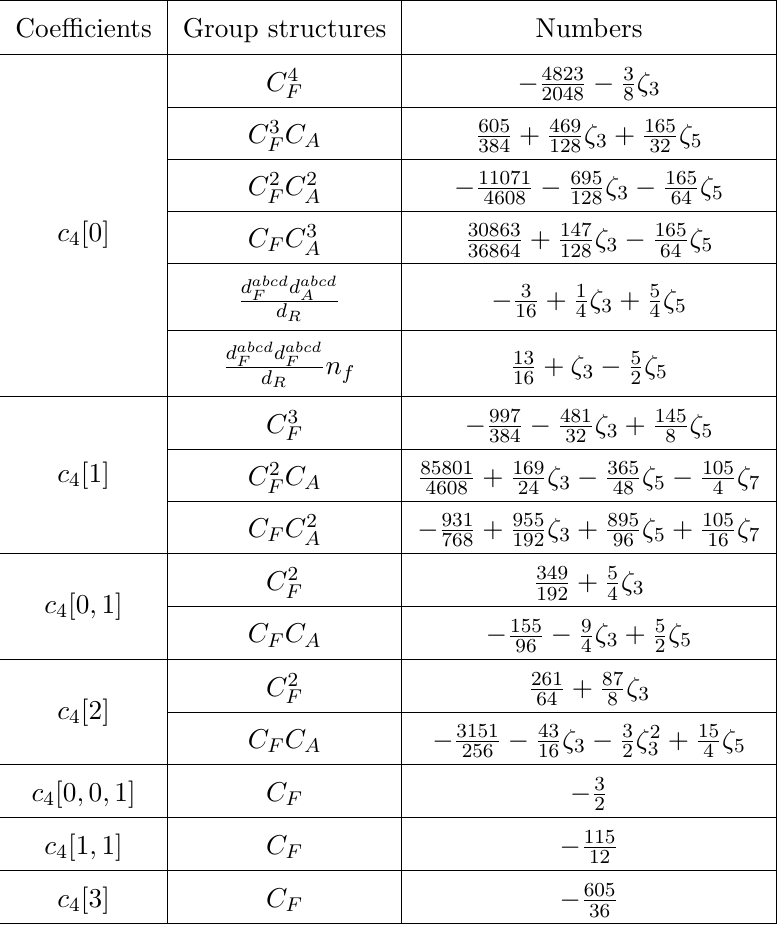
Table 5 . All terms included in the { β } -expansion of coefficient c 4